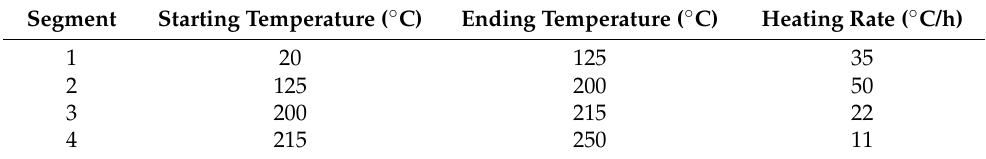
Table 2. Debinding process